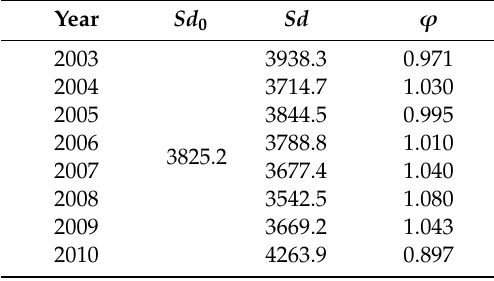
Table 2. Coe ffi cients reflecting the harshness of winter in the particular year of the examination